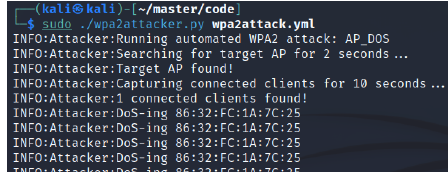
Figure 10. Performing the DoS attack.